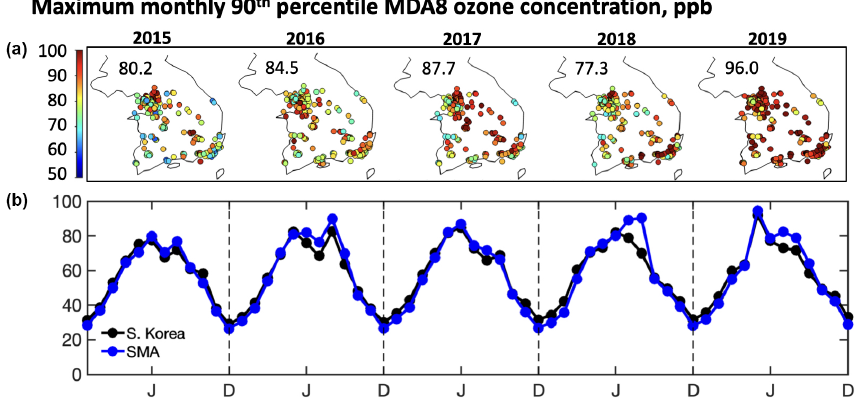
Figure 1. The 90th percentile maximum daily 8h average (MDA8) ozone concentrations in South Korea for 2015–2019. Panel (a) shows the maximum monthly 90th percentile ozone at individual AirKorea sites. The mean of this statistic across the ensemble of sites is shown inset. Panel (b) shows 90th percentile MDA8 ozone averaged for individual months over sites within the Seoul metropolitan area (SMA; 37.2–37.8 ◦ N, 126.7–127.3 ◦ E), as well as for all AirKorea sites. Tick marks are for June, and dashed lines are for December. Only sites with over 90% of observational coverage for the 2015–2019 period are included in this analysis.